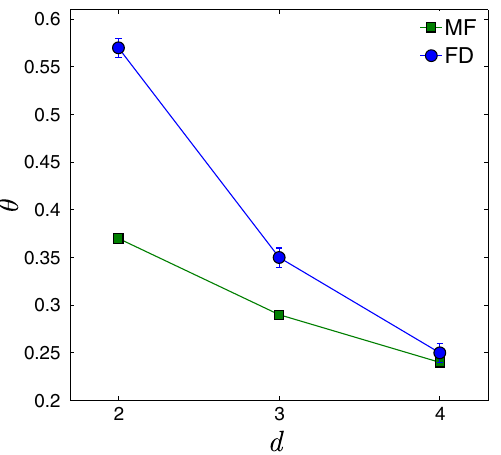
FIG. 7. Comparison between the measurements of the pseu- dogap exponent θ in finite-dimensional elastoplastic models (circle) and its mean-field prediction (square) as a function of the spatial dimension d . As d increases, the difference becomes smaller and undetectable for d ¼ 4